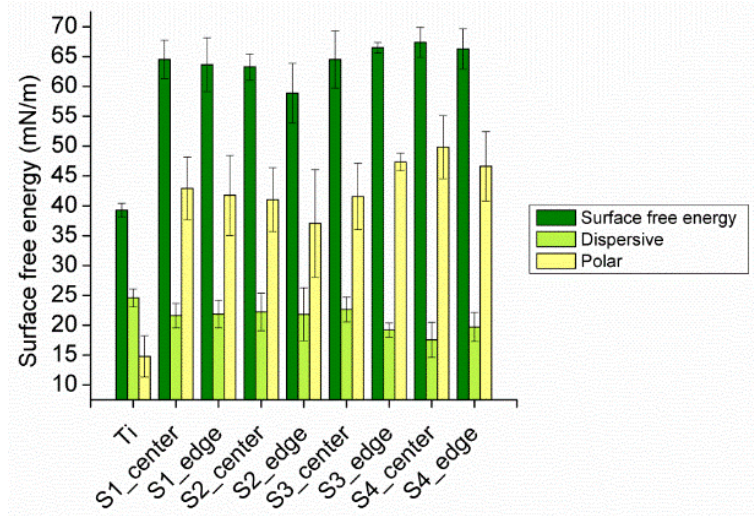
Figure 2. Surface free energy of plasma-polymerized, HEMA-based coatings on Ti samples for different sets of process parameters.